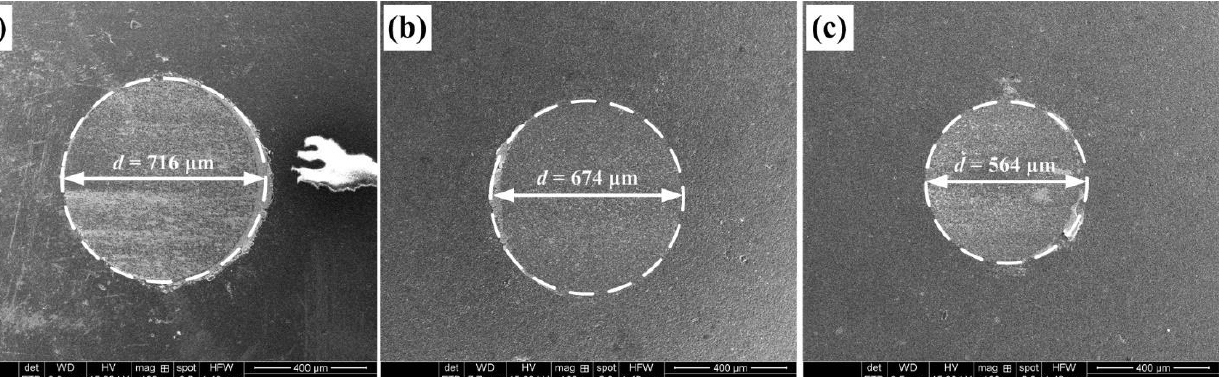
Figure 7. SEM images of the worn surface of the ceramic balls sliding with ( a ) SS, ( b ) TD150 and ( c ) TD150 with lubricants after 10 min dry operation at the speed of 40 m/min.